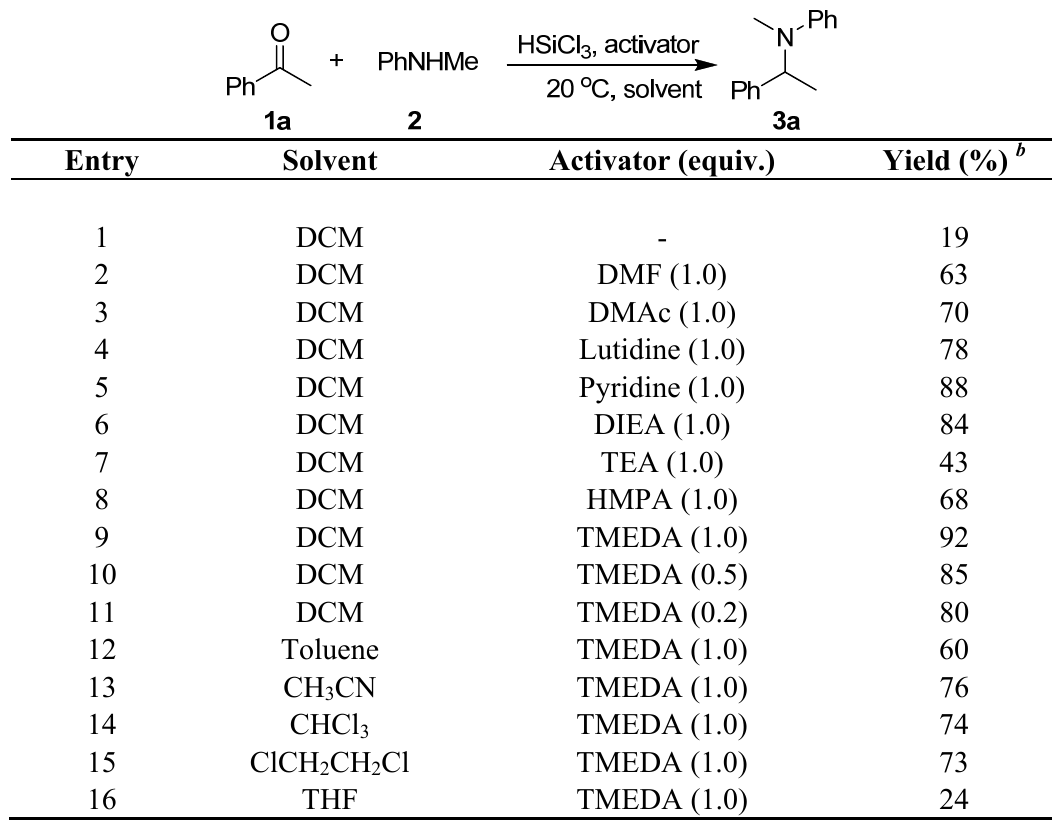
Table 1. Direct reductive amination under different conditions a